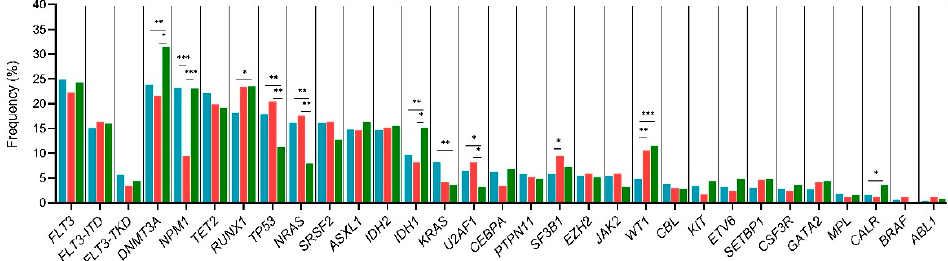
Figure 3. Mutational frequency according to disease stage. Blue bars: Diagnosis, green bars: Relapse and red bars: refractoriness. * p < 0.05, ** p < 0.01, *** p < 0.001. ITD: internal tandem duplication; TKD: tyrosine kinase domain.